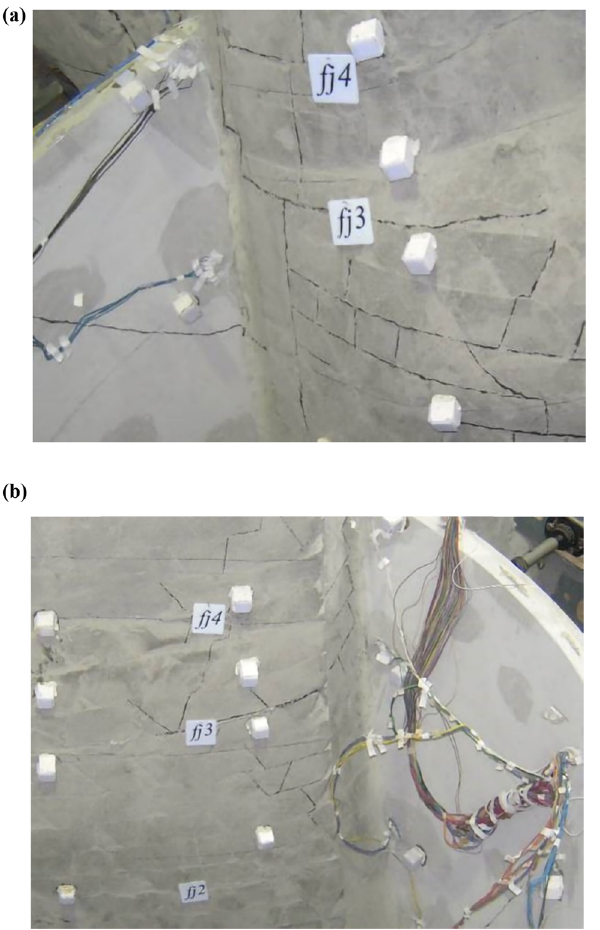
Figure 10: ( a ) Slip failure mode of left bank dam abutment. ( b ) Slip failure mode of right bank dam abutment.